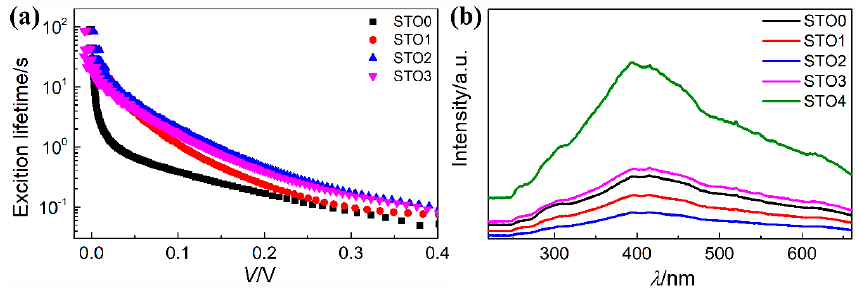
Figure 7. ( a ) the τ e (in log-linear representation) as a function of open-circuit voltage, ( b ) the photoluminescence (PL) spectra measured at room temperature of all samples on FTO substrates.